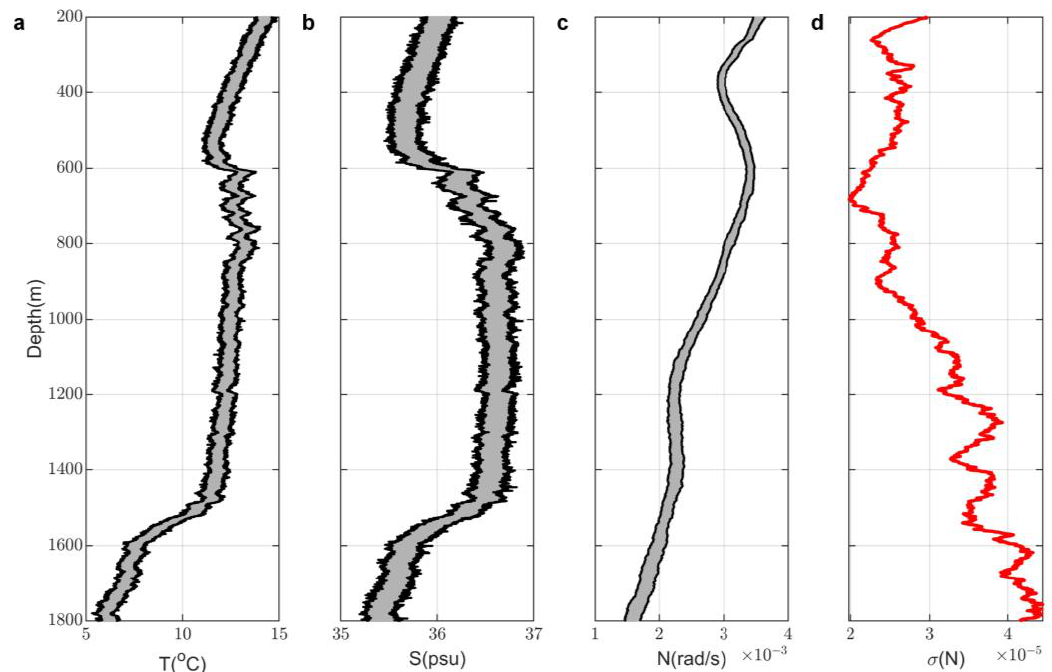
Figure A3. The T, S, N and σ ( N ) profiles with depth at CMP 1763. ( a ) Two hundred randomly drawn temperature profiles with depth. ( b ) Two hundred salinity profiles. ( c ) The smooth N profiles derived from T and S. ( d ) The standard deviation of N.